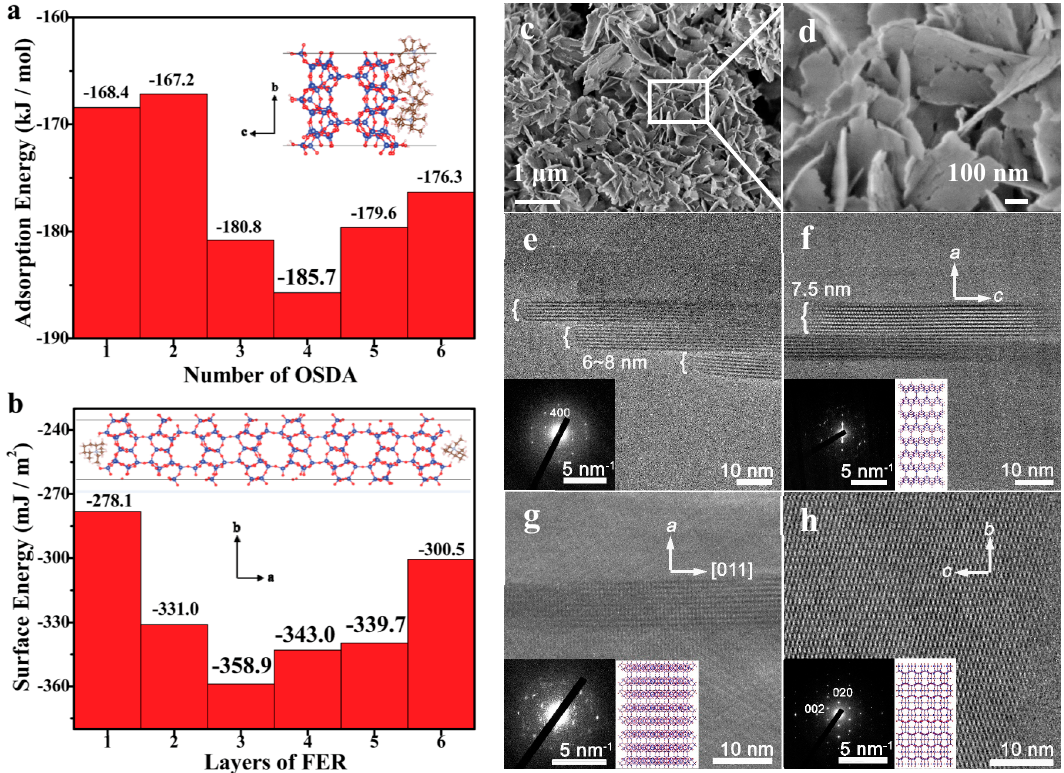
Figure 5. ( a ) Dependence of adsorption energy on FER {100} surfaces on the number of DMPi molecules and its schematic diagram, ( b ) dependence of surface energy on FER {100} on the number of layers of the FER structure and its schematic diagram, ( c , d ) SEM images, ( e – h ) TEM images of the nanosheets of aluminosilicate FER zeolites and corresponding projections of the FER framework along ( f ) [010], ( g ) [0 – 11] and ( h ) [100], respectively. Reprinted with permission from ref. [61]. Copyright 2019, The Royal Society of Chemistry.